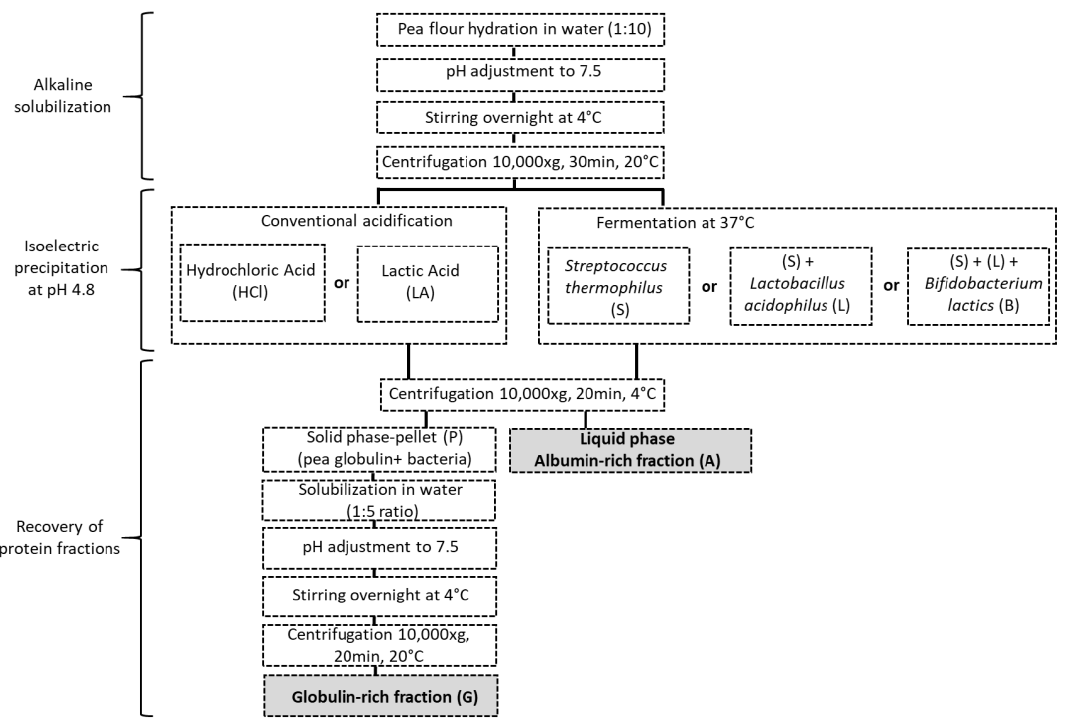
Figure 1. Pea protein extraction method .